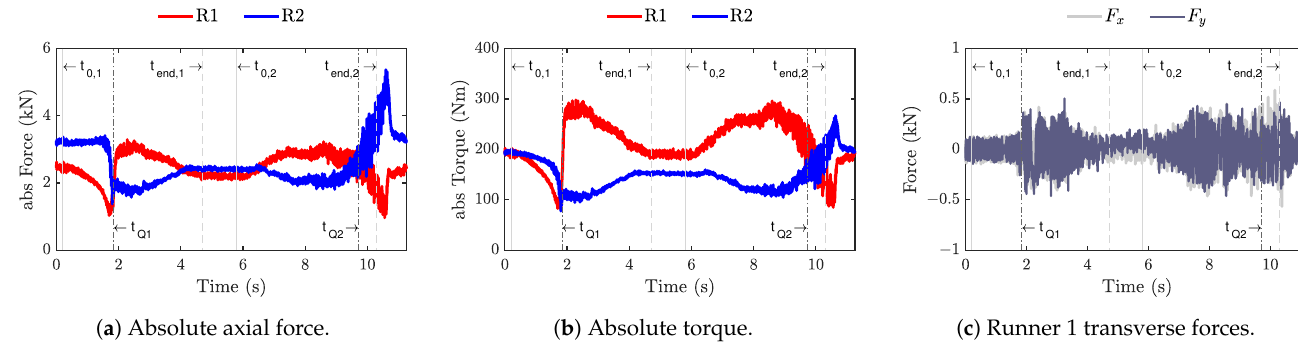
Figure 12. Axial force and torque on the runners and transverse forces for Runner 1, as a function of time during the transient sequences in pump mode. The z -component is the axial